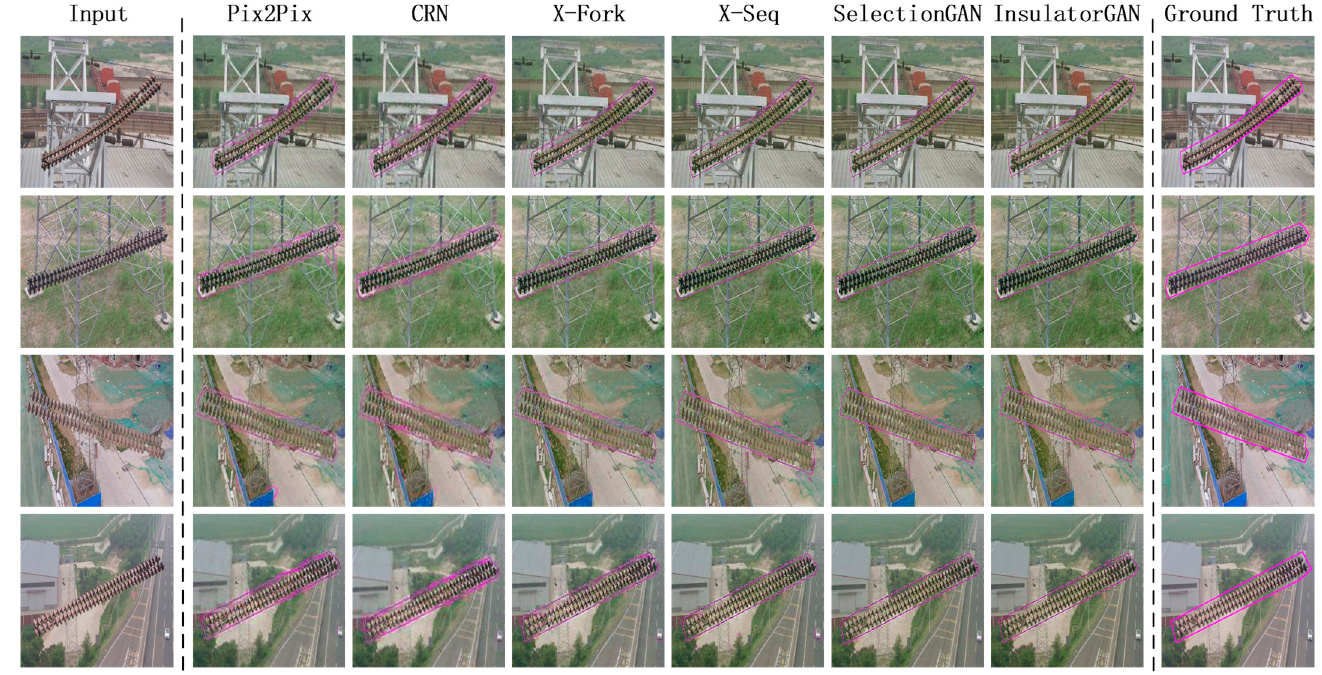
Figure 6. Test examples of each model on the CPLID dataset.